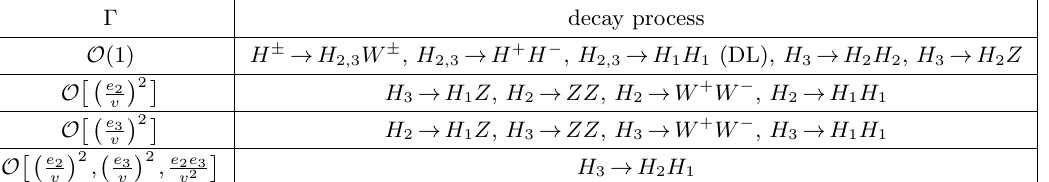
Table 5 . Coe(cid:14)cients of H i H + W (cid:0) panded around the AL up to O ( e 2 ; 3 =v ). The second, third and fourth columns show the alignment result and coe(cid:14)cients of e 2 =v and e 3 =v , respectively.